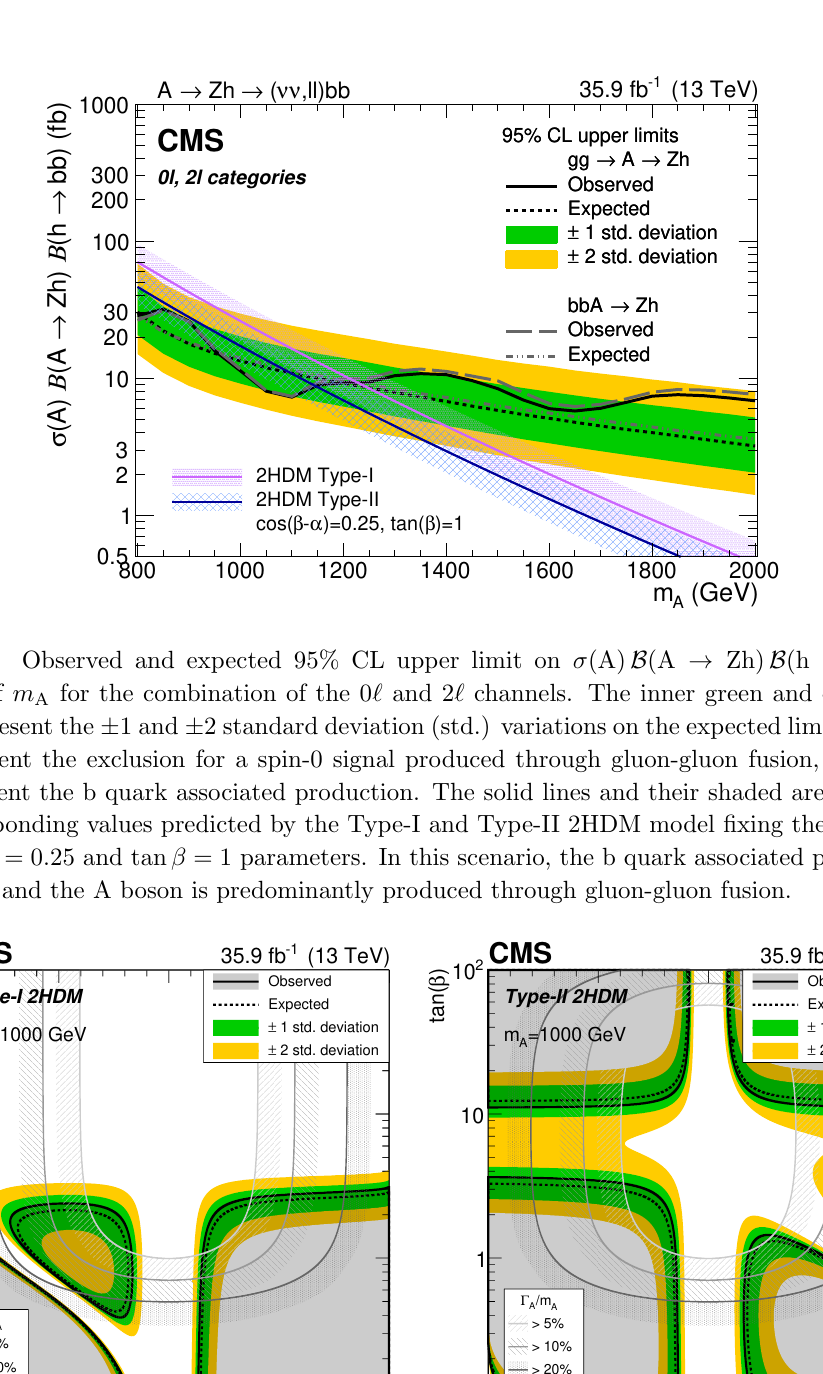
Figure 9 . Observed and expected exclusion limit for Type-I (left) and Type-II (right) 2HDM models in the [tan (cid:12) , cos( (cid:12) (cid:11) ) ] plane and assuming a (cid:12)xed m A = 1 TeV. The inner green and (cid:0) outer yellow bands represent the 1 and 2 standard deviation (std.) variations on the expected (cid:6) (cid:6) limit. The contour lines and associated shading identify regions with di(cid:11)erent resonance natural width (5, 10, and 20% of the resonance mass).